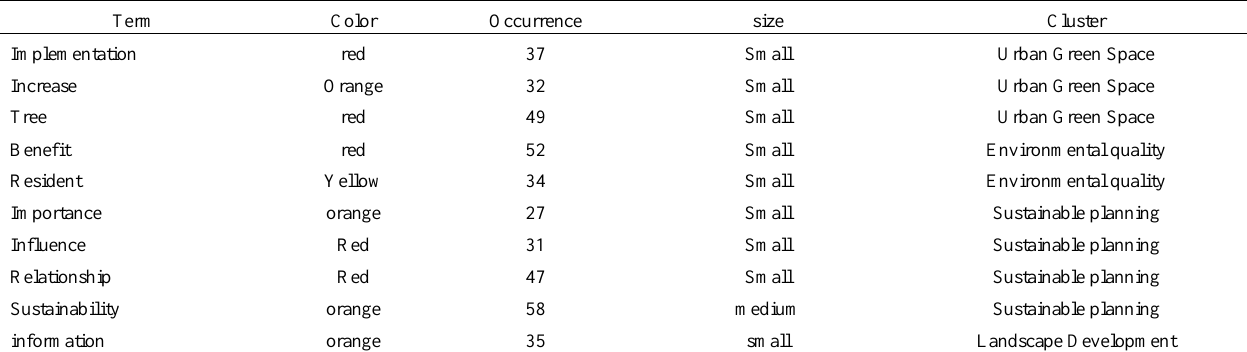
Table 3. The hot topic of document collection base on citation impact